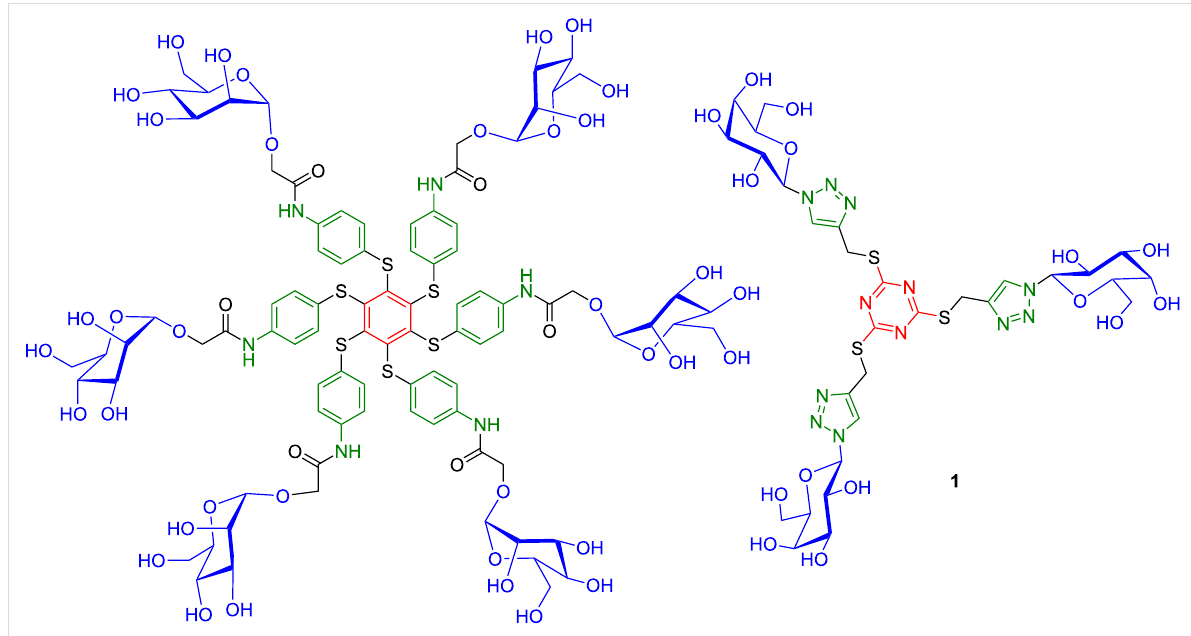
Figure 1: Previously reported low-valent glycoasterisk α -D-Man ligand based on a persulfurated benzene core [30] and currenly reported β -D-Gal compound 1